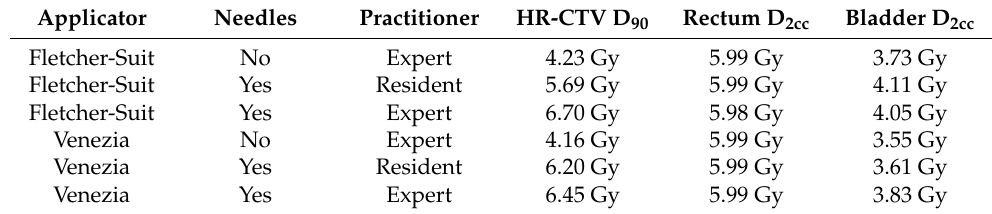
Table 1. Dose-volume parameters for the treatment plans in the trial use of the IC/IS training simu- lator .